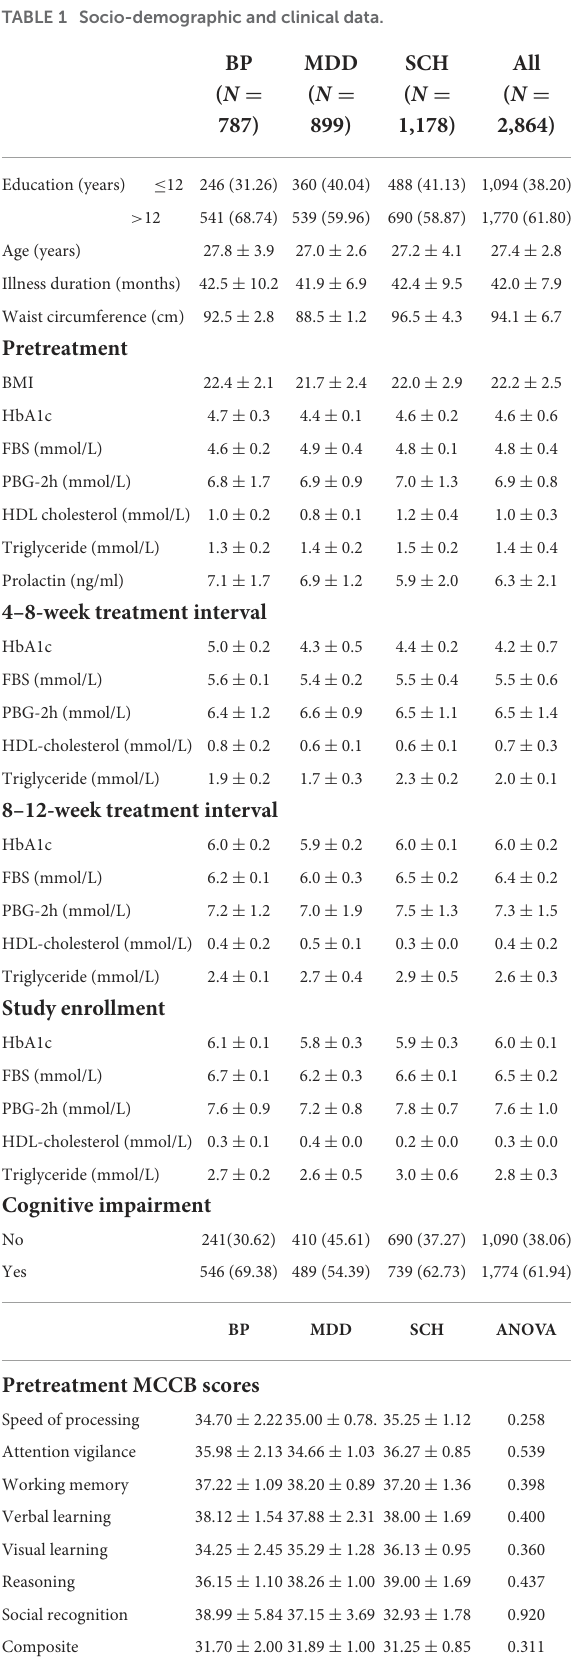
TABLE 1 Socio-demographic and clinical